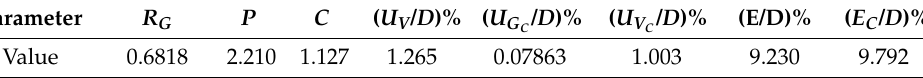
Table 3. Verification and validation of lift coefficient.